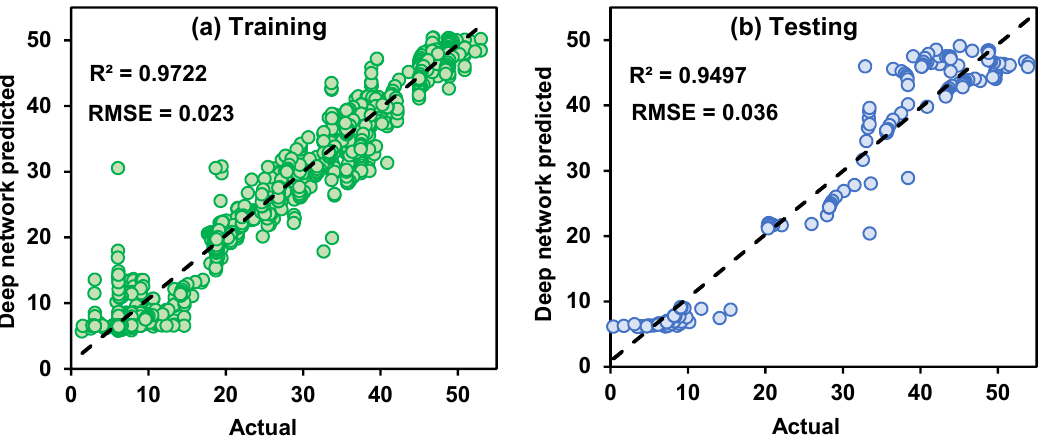
Figure 13. Deep NN optimized model with six neurons each in 5 hidden layers using Gaussian function in each neuron during ( a ) training and ( b ) testing.